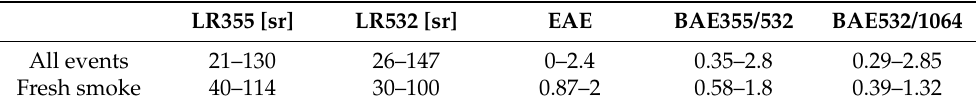
Table 1. Range of the smoke’s optical properties in literature, based on the review in